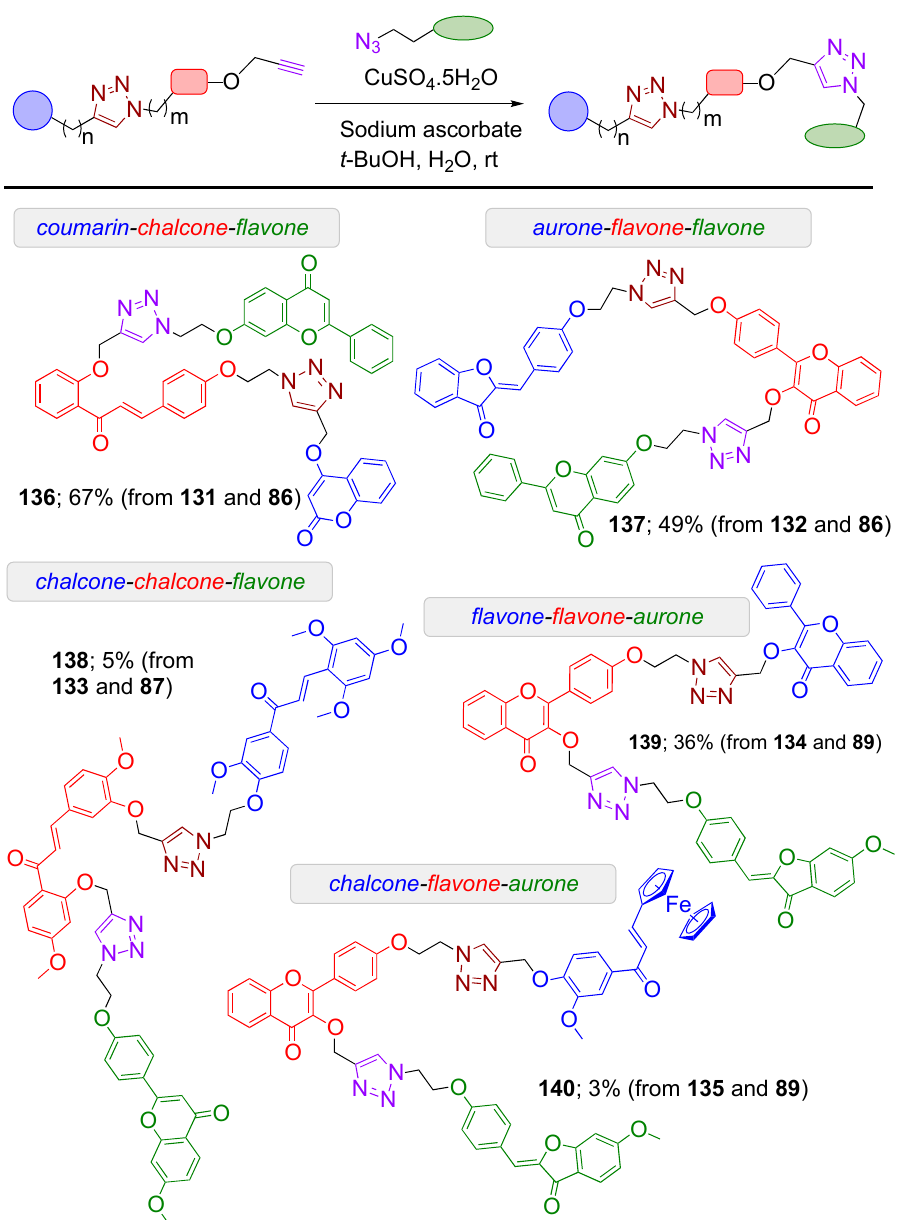
Scheme 21. Synthesis of triazole-bridged trimers.